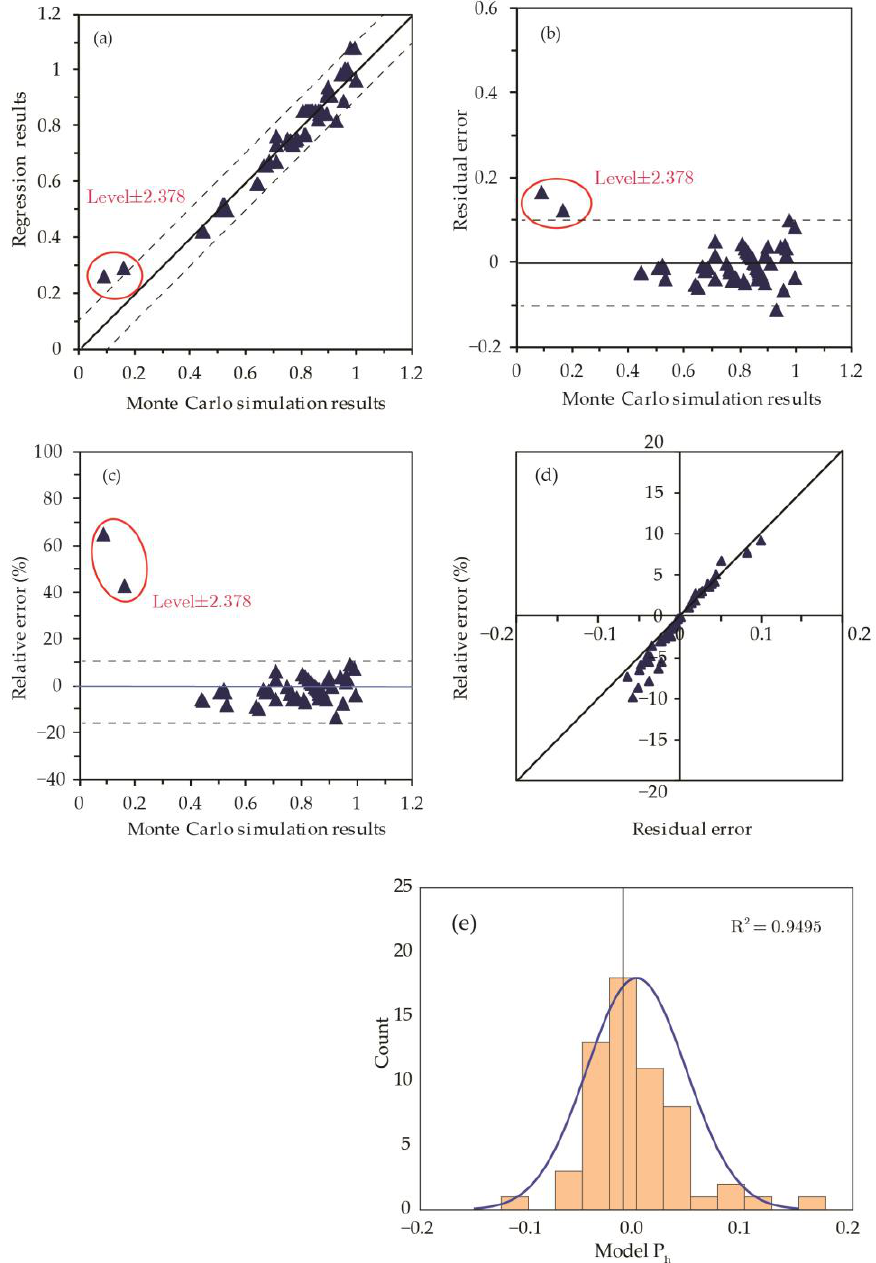
Figure 7. Comparison of regression models for P h . ( a ) Regression and Monte-Carlo simulation results; ( b ) residual error; ( c ) relative error; ( d ) relative error against residual error; and ( e ) relative error distribution for P h .